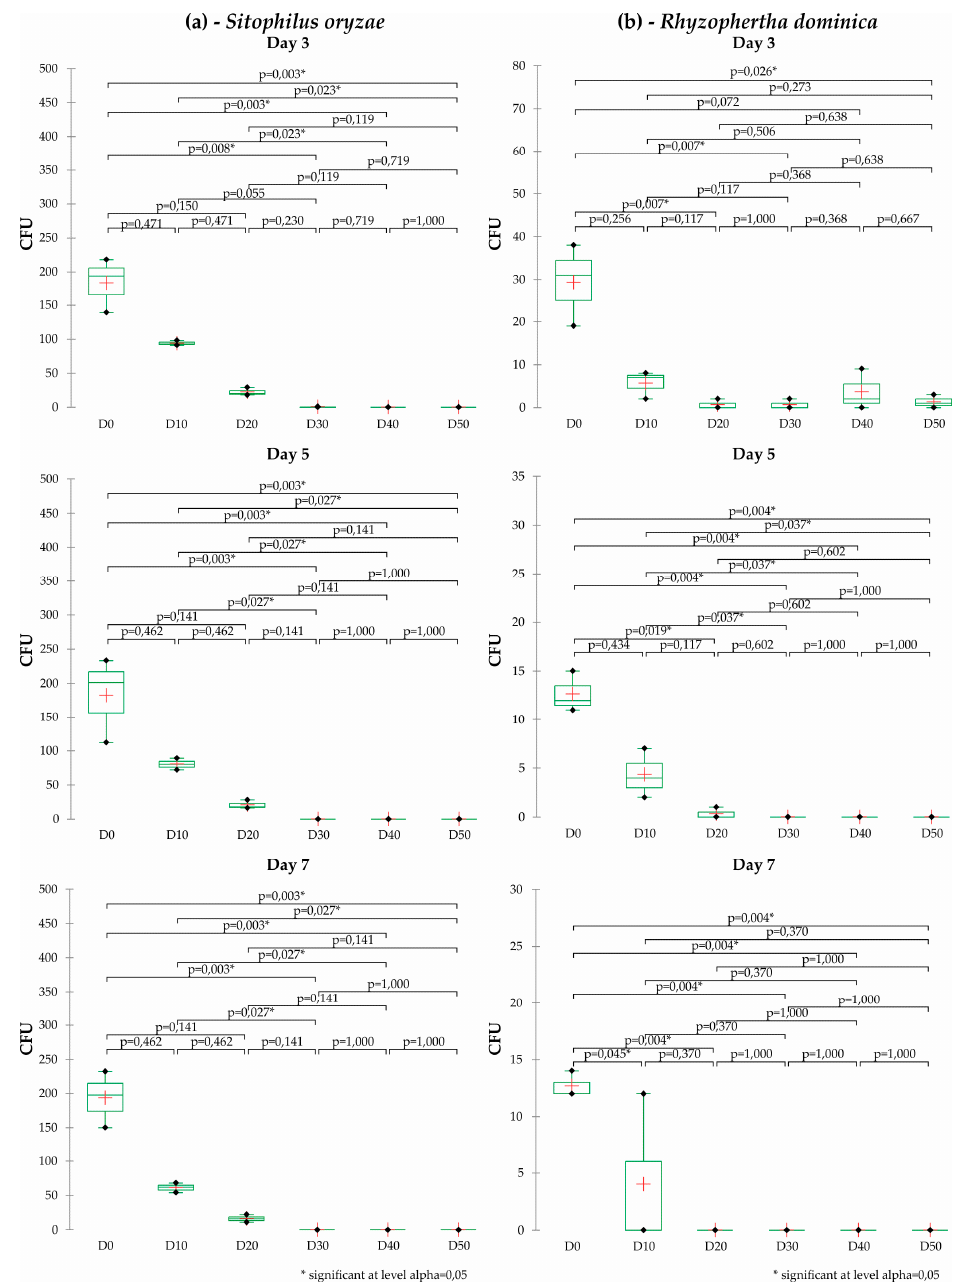
Figure 2. Boxplot showing changes in the number of bacteria (colony-forming units (CFU) in the consecutive days of culture on food contaminated with antibiotics (the initial number of bacteria for S. oryzae was 201 CFU and for R. dominica 40 CFU); D0: no antibiotic in the diet, D10 to D50: doses from 10 to 50 mg·g − 1 of the antibiotic in the feed.